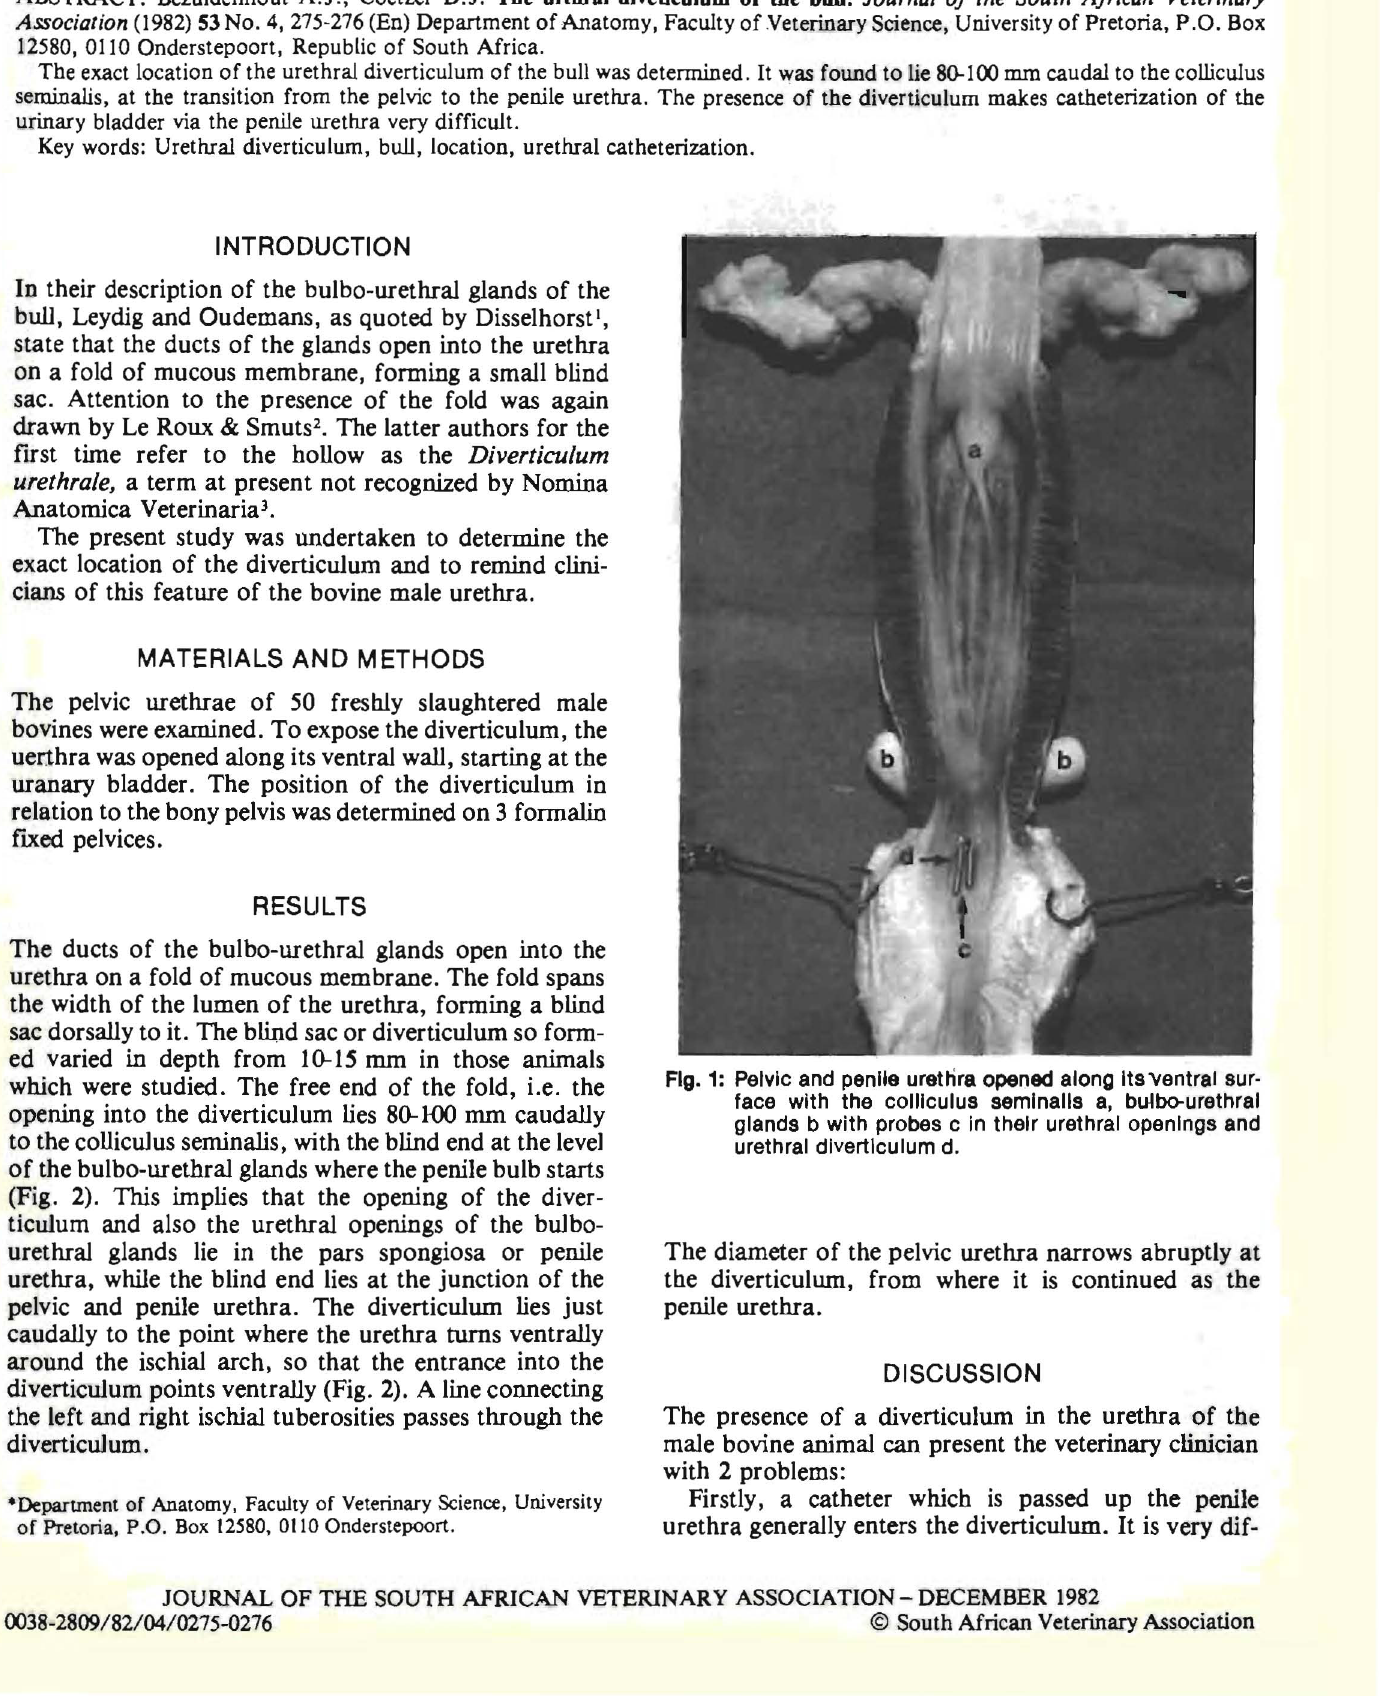
Fig. 1: Pelvic and penile urettira opened along Its ventral sur· face with the colliculus semlnalls a, bulbo-urethral glands b with probes c In their urethral openings and urethral diverticulum